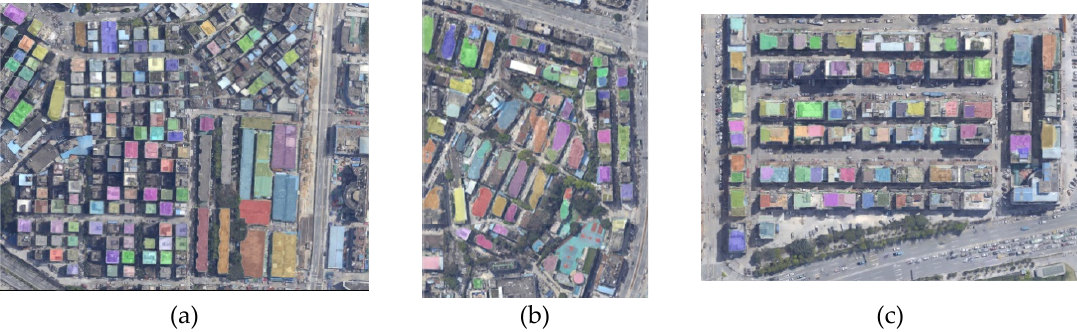
Figure 13. Bounding box and mask area of building using the mask region-based convolutional neural network (R-CNN) method for three training dataset. ( a ) region 1, ( b ) region 2, and ( c ) region.